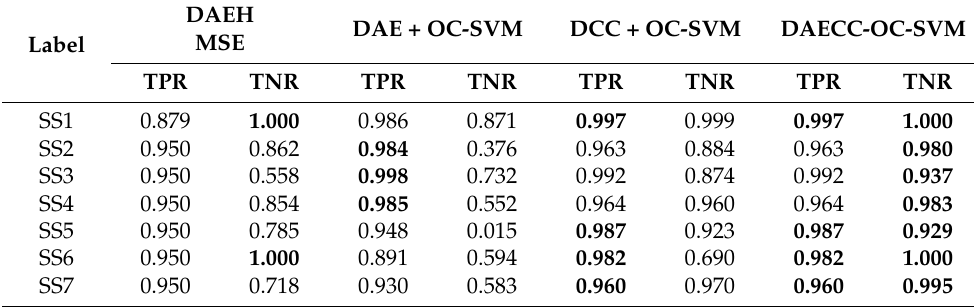
Table 6. Comparison of performance of anomaly detection in terms of TPR and TNR on CWRU